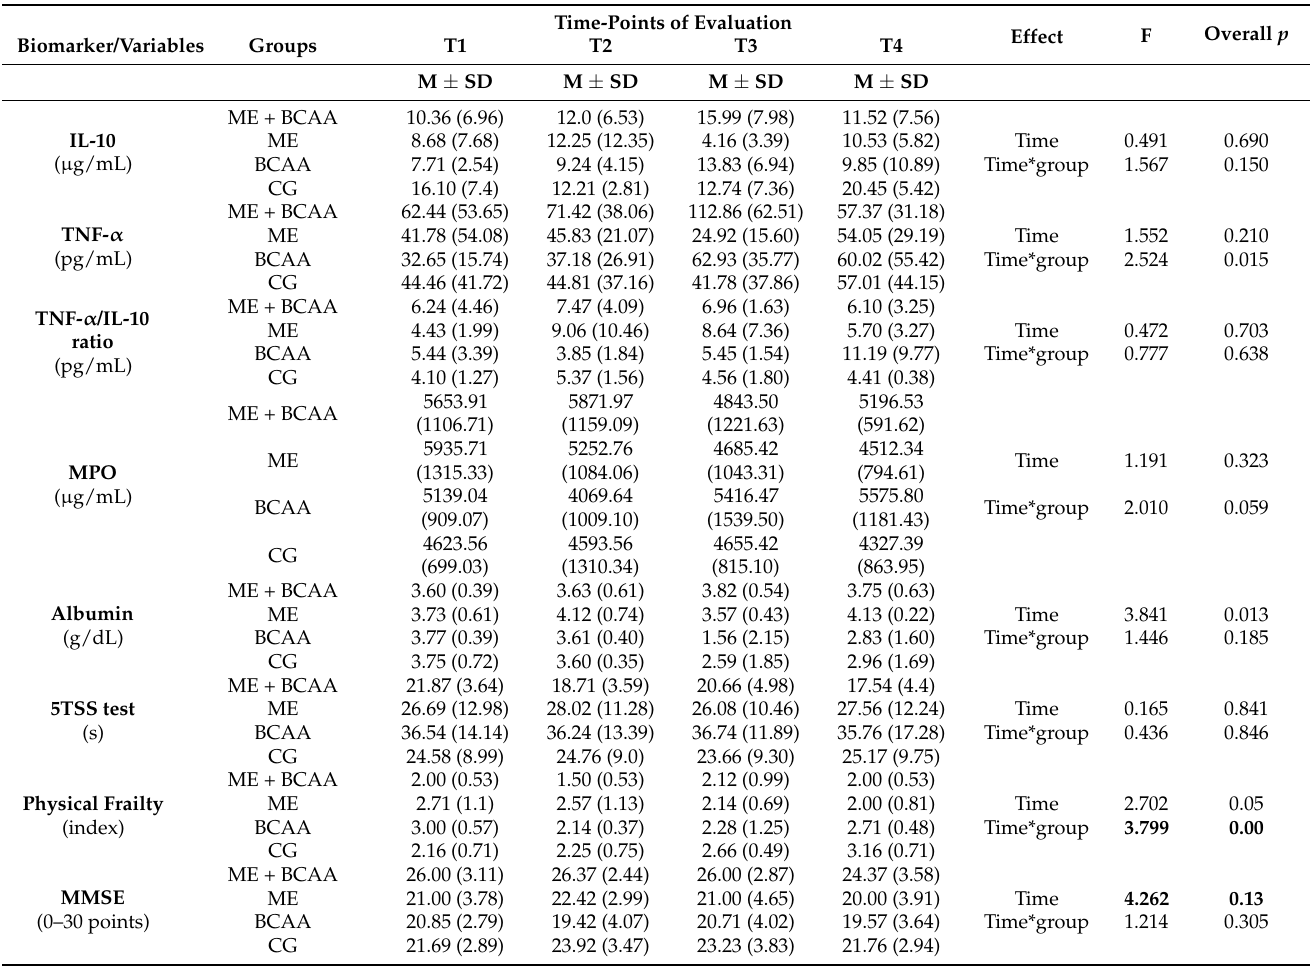
Table 4. Statistical analysis comparison of four time-points moments of multifactorial intervention for biochemical, cognitive profile, physical frailty index, and functional fitness